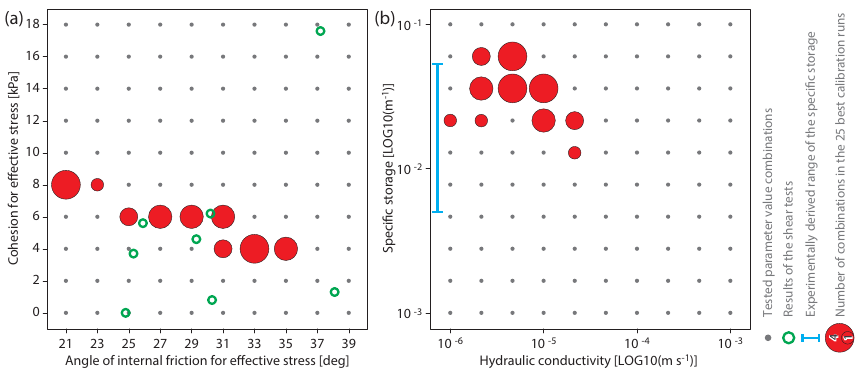
Figure 12. Calibrated values for the geotechnical (a) and hydrological parameters (b) . The sizes of the red circles indicate the number of model runs based on these value pairs (with varying values of the further tested parameters). The results of the shear tests are shown in (a) as green circles. The experimentally derived range of the specific storage is indicated by the blue bar in (b) .